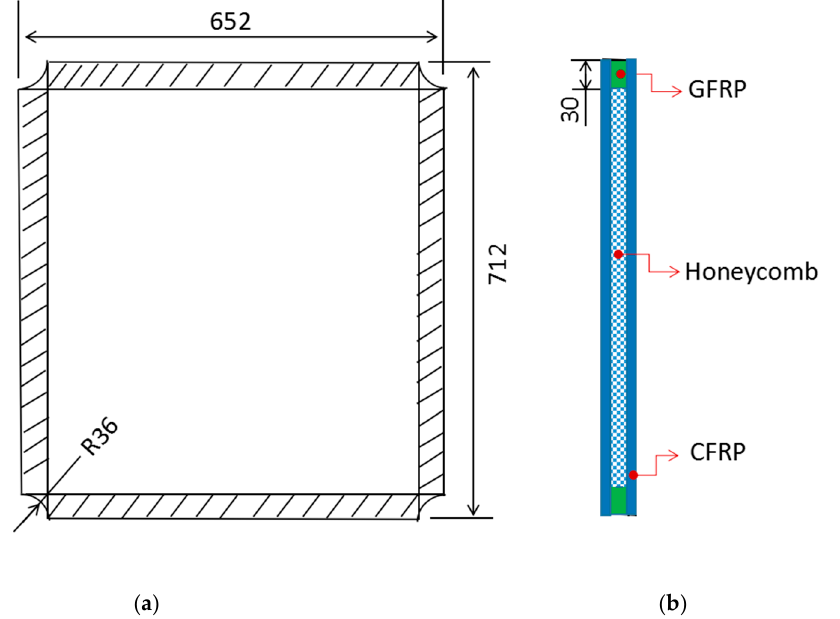
Figure 2. Schematic diagram of geometric dimension of the Nomex honeycomb sandwich CFRP panel: ( a ) top view of specimen; ( b ) side view of specimen (unit: mm).